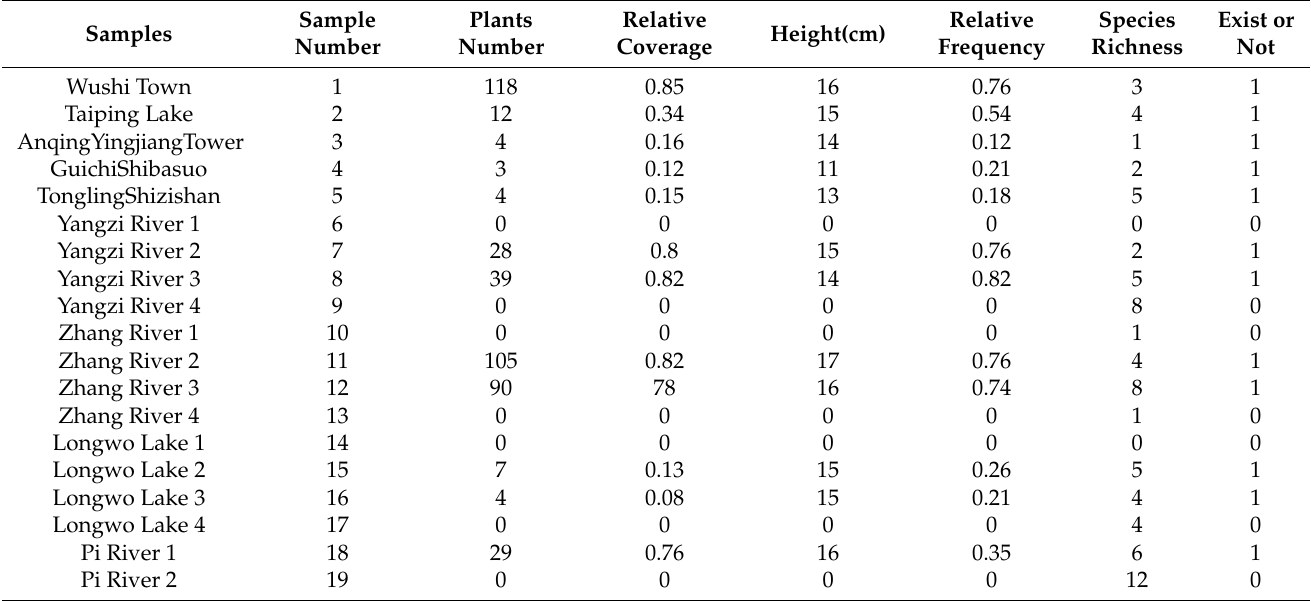
Table 4. Characteristics of ecological factors of P. criopolitanum .